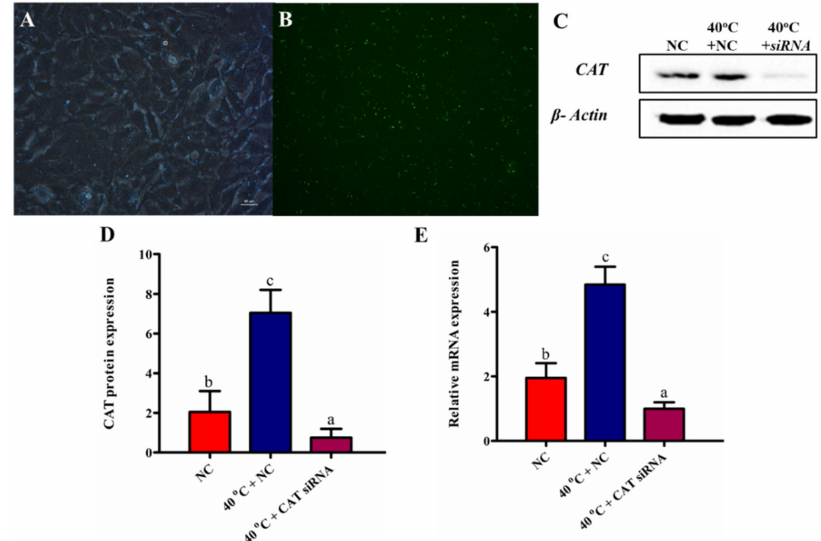
Figure 3. Detection of CAT siRNA e ffi cacy in GCs ( A , B ). After transfection, the CAT protein expression was detected by Western blotting in GCs ( C , D ). Transcription levels of the CAT gene among all treated groups ( E ). Values are expressed as mean ± SEM of n = 3. Superscripts (a, b, c) represent a significant ( p < 0.05) di ff